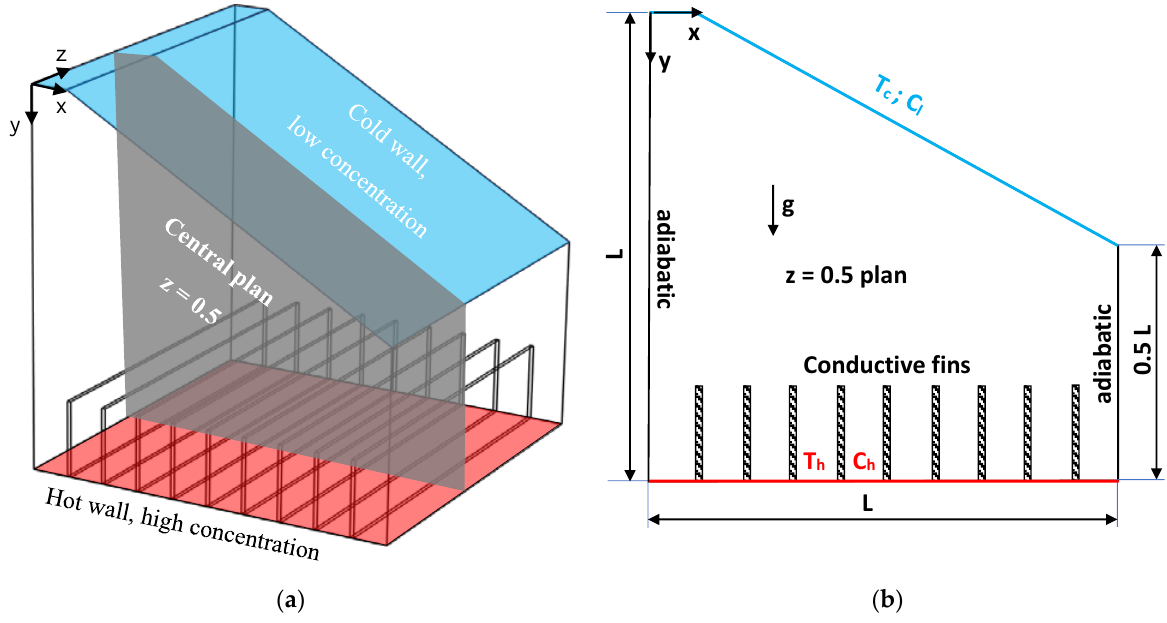
Figure 1. Studied configuration: ( a ) 3D model; ( b ) central plan (z = 0.5).